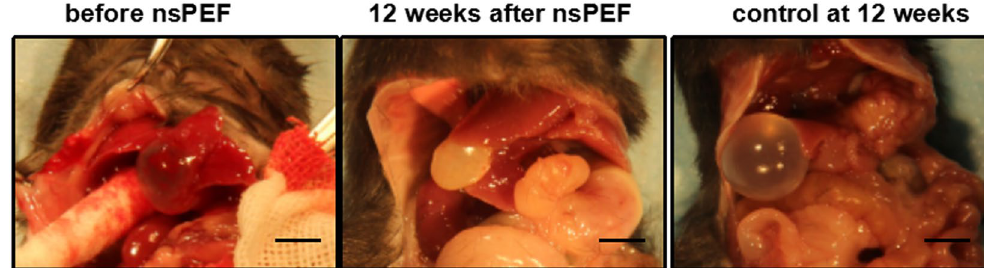
Figure 5. The gross anatomy changes of mouse cystic echinococcosis lesion. During the open check, the real appearance of mouse cystic echinococcosis lesion before and after nsPEF treatment were imaged for comparison. The scale bar is 1 cm.